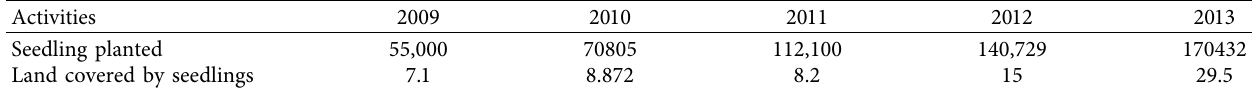
Table 8: Seedlings planted in the natural forest for the last five years.